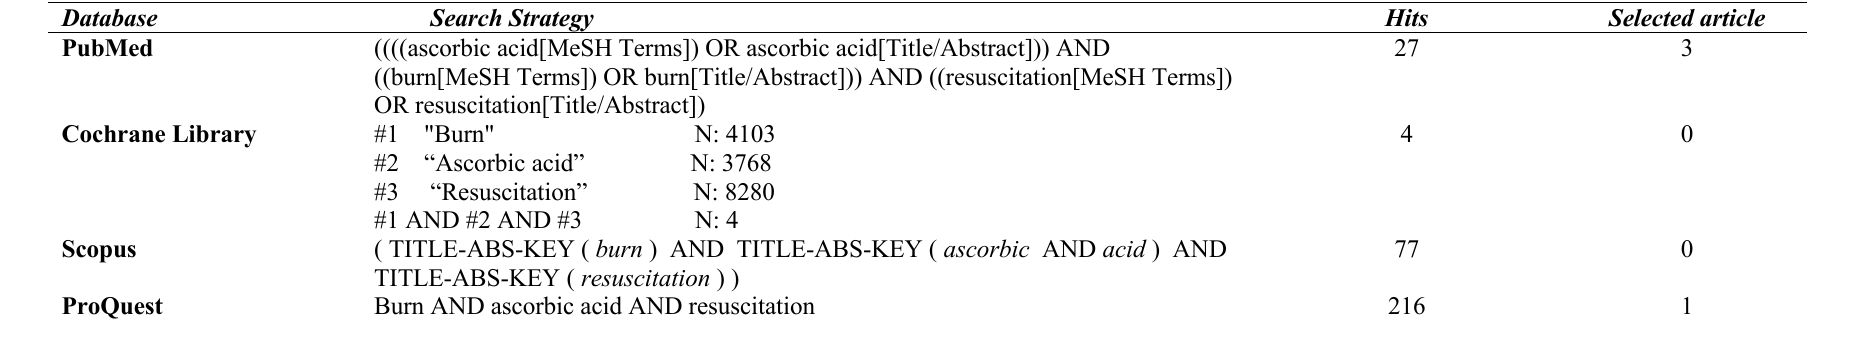
Table 1. Resources & search strategy